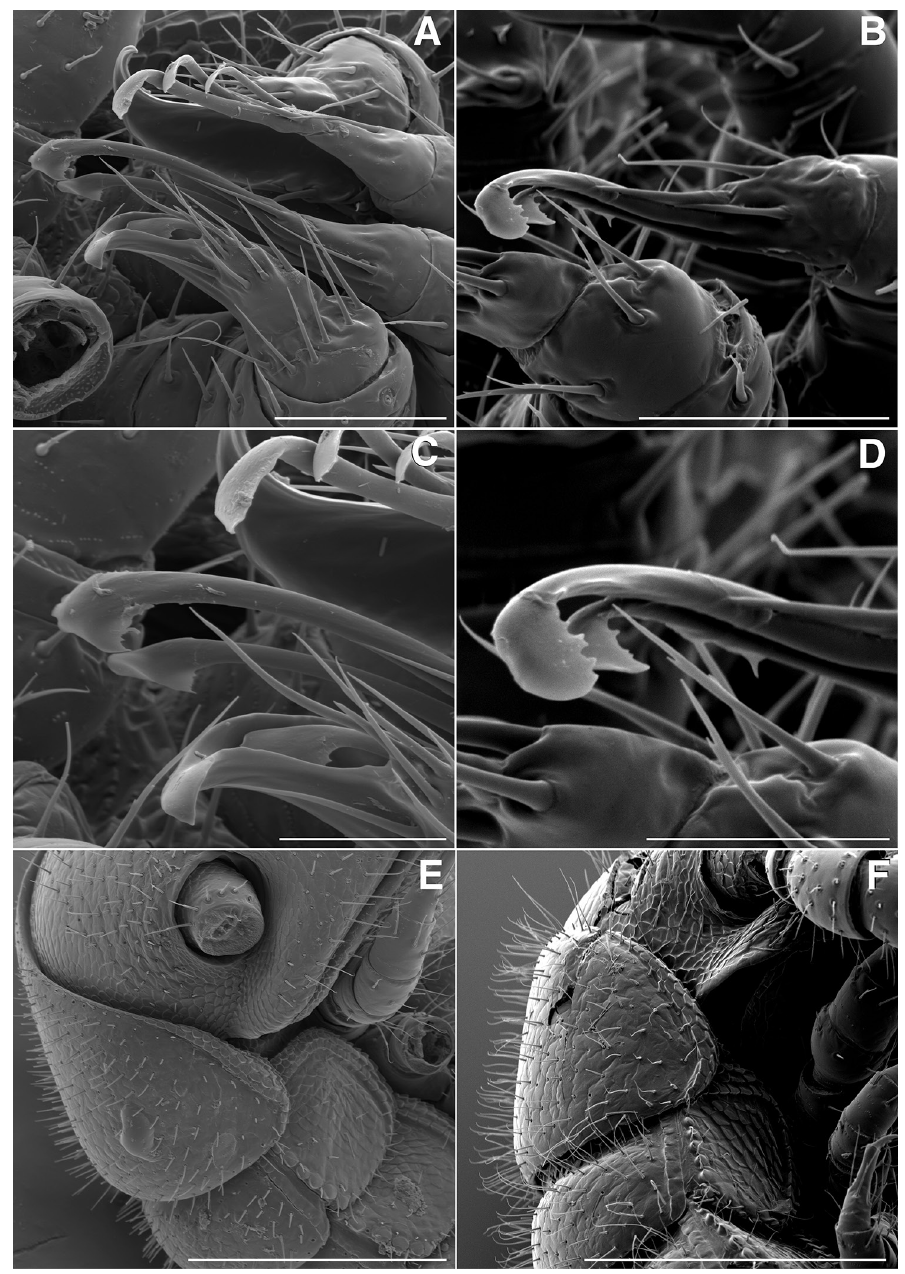
Figure 5. A Lateral (right) view of gonopods of I. tobini sp. n. (centered on right posterior gonopod) (scale bar 50 µm) B the same of I. plenipes (scale bar 50 µm) C Lateral (right) view of right posterior gonopod apex of I. tobini sp. n. (scale bar 25 µm) D the same of I. plenipes (scale bar 25 µm) E Lateral (right) view of head, collum, and rings 2, 3 of I. tobini sp. n. (scale bar 200 µm) F the same of I. plenipes (scale bar 200 µm). (Catalog #s: I. tobini sp. n. MPE00735, I. plenipes